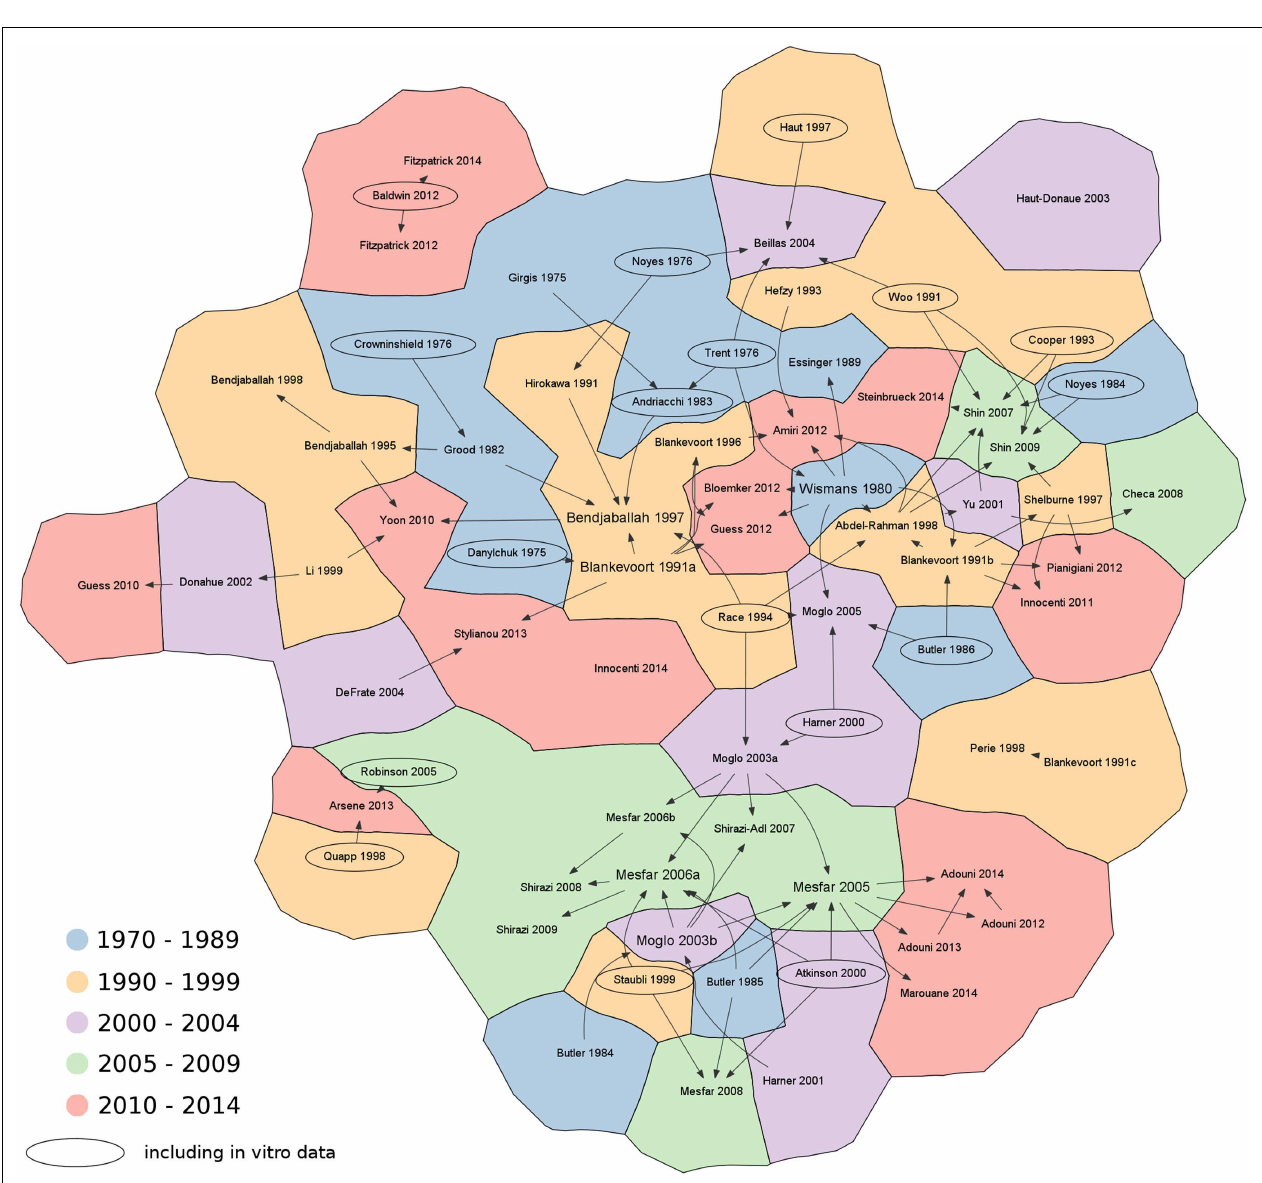
FIGURE 3 | Citation chart showing the sources of each paper retrieved in the literature using 1D elements to represent the knee ligaments . Arrows indicate the papers used as reference for the material properties of the ligaments. Studies including in vitro data are highlighted with an oval border. For the sake of brevity, only the name of the first author is shown. References not reported in the main text: Abdel-Rahman and Hefzy, 1998; Adouni